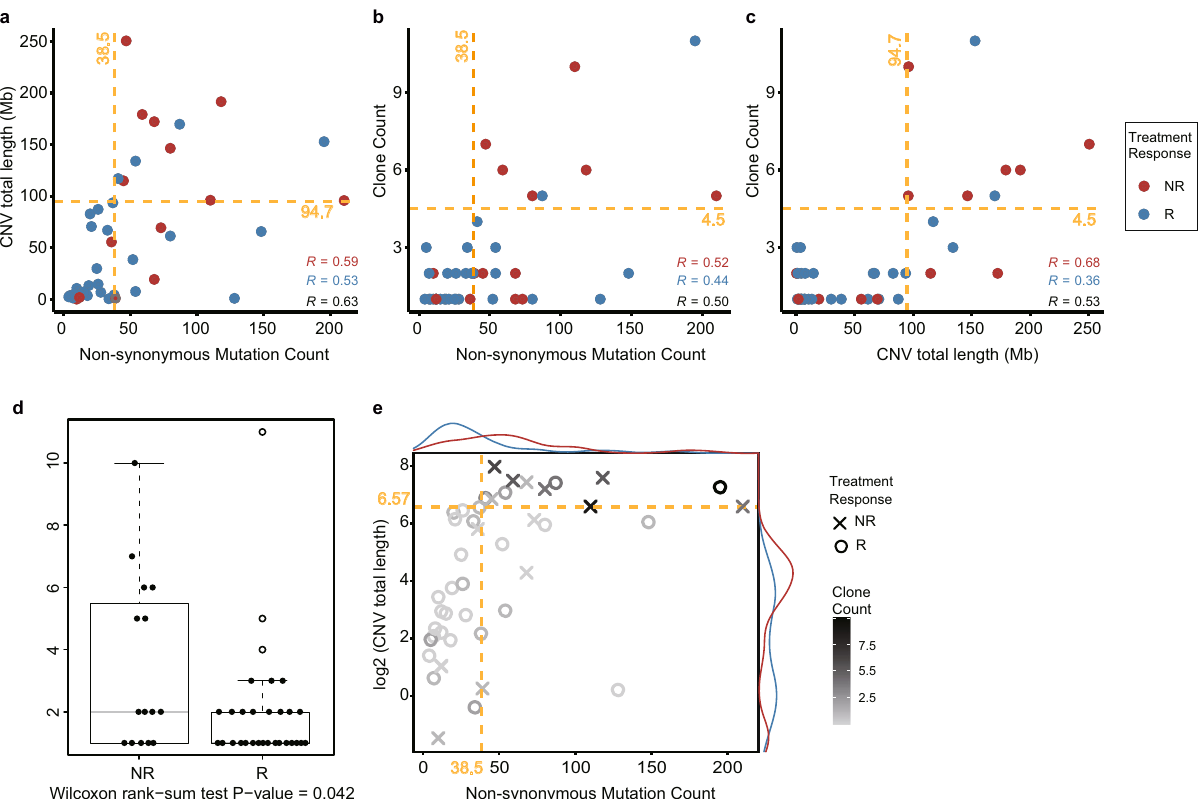
Fig. 5 Comparison of CNVs, nonsynonymous mutations, and the number of clones. a Correlation between total size of CNVs and nonsynonymous mutations. Correlation between number of clones and b nonsynonymous mutations and c total size of CNVs. d Comparison of the number of clones between responders and non-responders. e The number of clones increased in patients with both higher numbers of nonsynonymous mutations and larger CNVs. The color variation from black to light gray indicates higher to lower clone numbers, respectively. The suggested cut-off of each feature for distinguishing extreme responders from non-responders is marked with yellow line. The copy number burden has more discriminative power than various feature combinations owing to the high coef fi cient of variation (nonsynonymous mutations: 0.97, CNV: 1.11, clone: